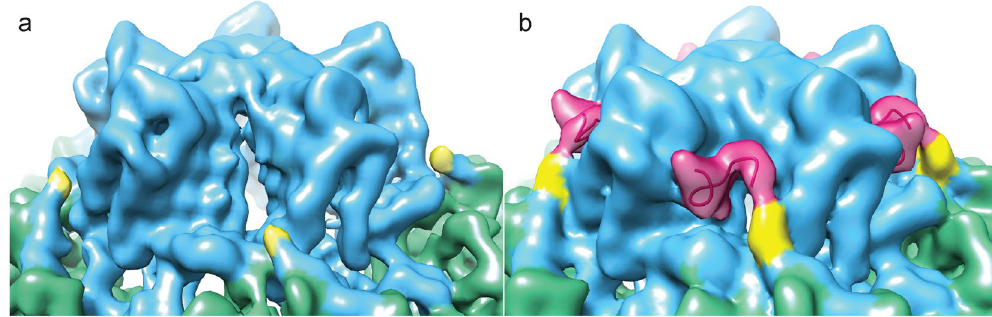
Figure 7. The C terminus extension of S subunit. ( a ) The unsharpened EM density map of CPMV-M. The S subunit is coloured blue and the L subunit is in green. The C terminal amino acid in the CPMV-M map is Ser183 and is coloured yellow. ( b ) The unsharpened EM density map of CPMV-T. Coloured as in ( a ). Amino acids Ser183 and Thr184 are coloured yellow. The C terminus extension, only visible in the CPMV-T map, amino acids Pro188 to Ile197 are coloured